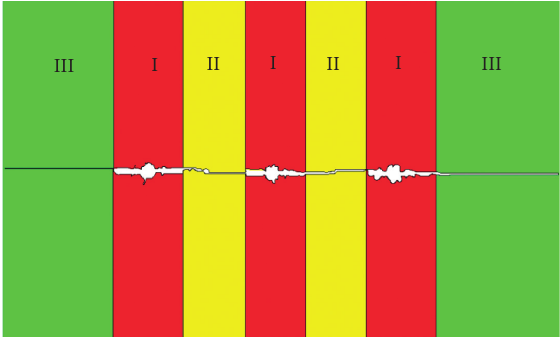
Figure 8: Crack zoning of blasted